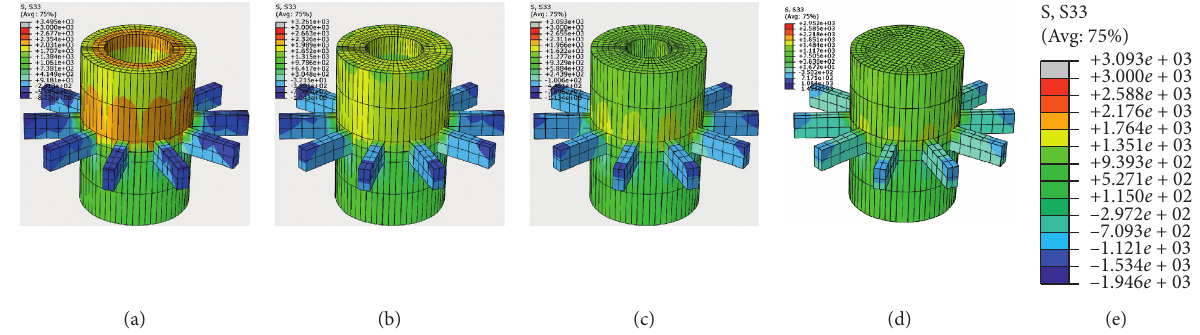
Figure 17: Axial stress distribution of piles of 2.0m in diameter with different wall thickness. (a) 0.3m. (b) 0.55m. (c) 0.7m. (d) Solid pile. (e) The legend.